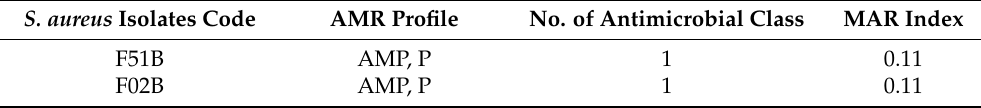
Table 3. Antimicrobial resistance profile of S. aureus isolates from bovine subclinical mastitis. S. aureus Isolates